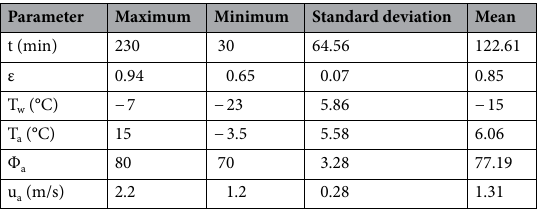
Table 1. The details of experimental frost thermal